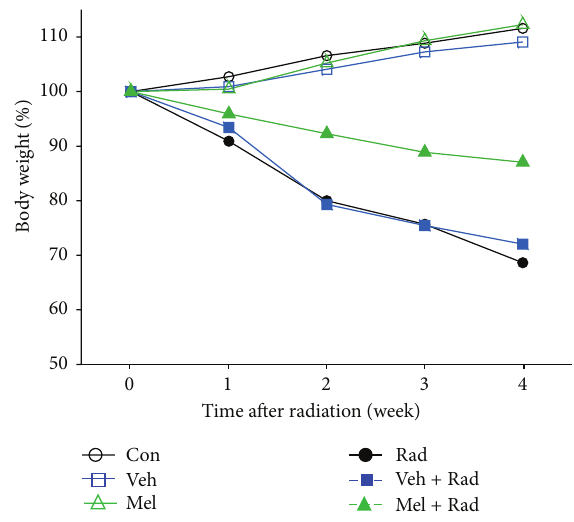
Figure2:Percentchangeinbodyweightofrats.Con:Controlgroup, Veh: Vehicle only group, Mel: Melatonin only group, Rad: Radiation only group, Veh + Rad: Treated with vehicle and exposed to 10Gy radiation, and Mel + Rad: Treated with 100mg/kg melatonin before exposure to 10Gy radiation.